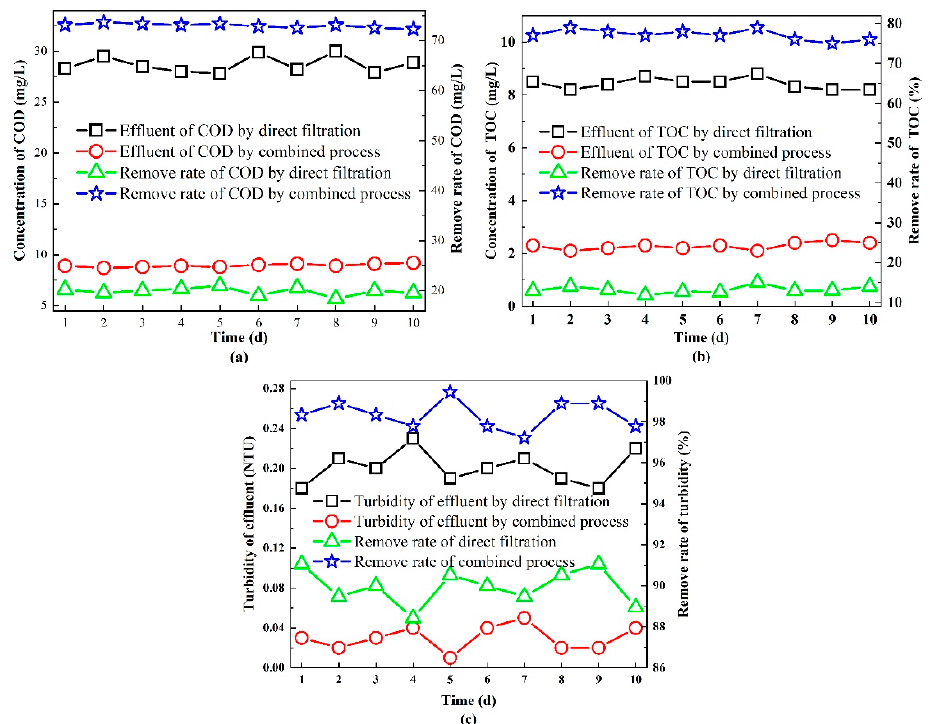
Figure 2. Removal of organic pollutants and turbidity using direct filtration and combined processes: ( a ) the removal of TOC from the refinery wastewater; ( b ) the removal of COD from the refinery wastewater; ( c ) the removal of turbidity from the refinery wastewater.